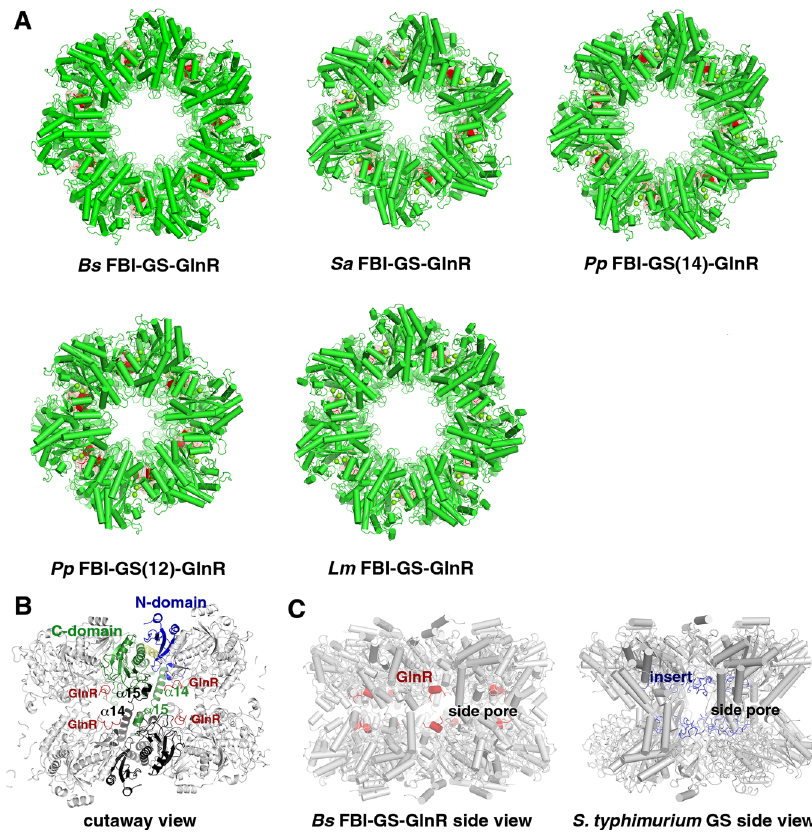
Fig. 3 Cryo-EM structures of Bs, Sa, Pp , and Lm FBI-GS-GlnR C-tail complexes. A Shown are the top views of the structures for Bs, Sa, Pp , and Lm FBI-GS- GlnR C-tail complexes. GS subunits are colored green and GlnR, red. B Domain architecture of GS and the α 14- α 15 to α 14 ″ – α 15 ″ thong interactions linking the two rings (where ″ indicates subunit from the other ring). C Comparison of the side view of the GlnR-bound GSI- α to the GSI- β from S. typhimurium showing how GlnR (red) binds in the side pore in the same location as the 25-residue insert (blue) found in GSI- β but not GSI- α